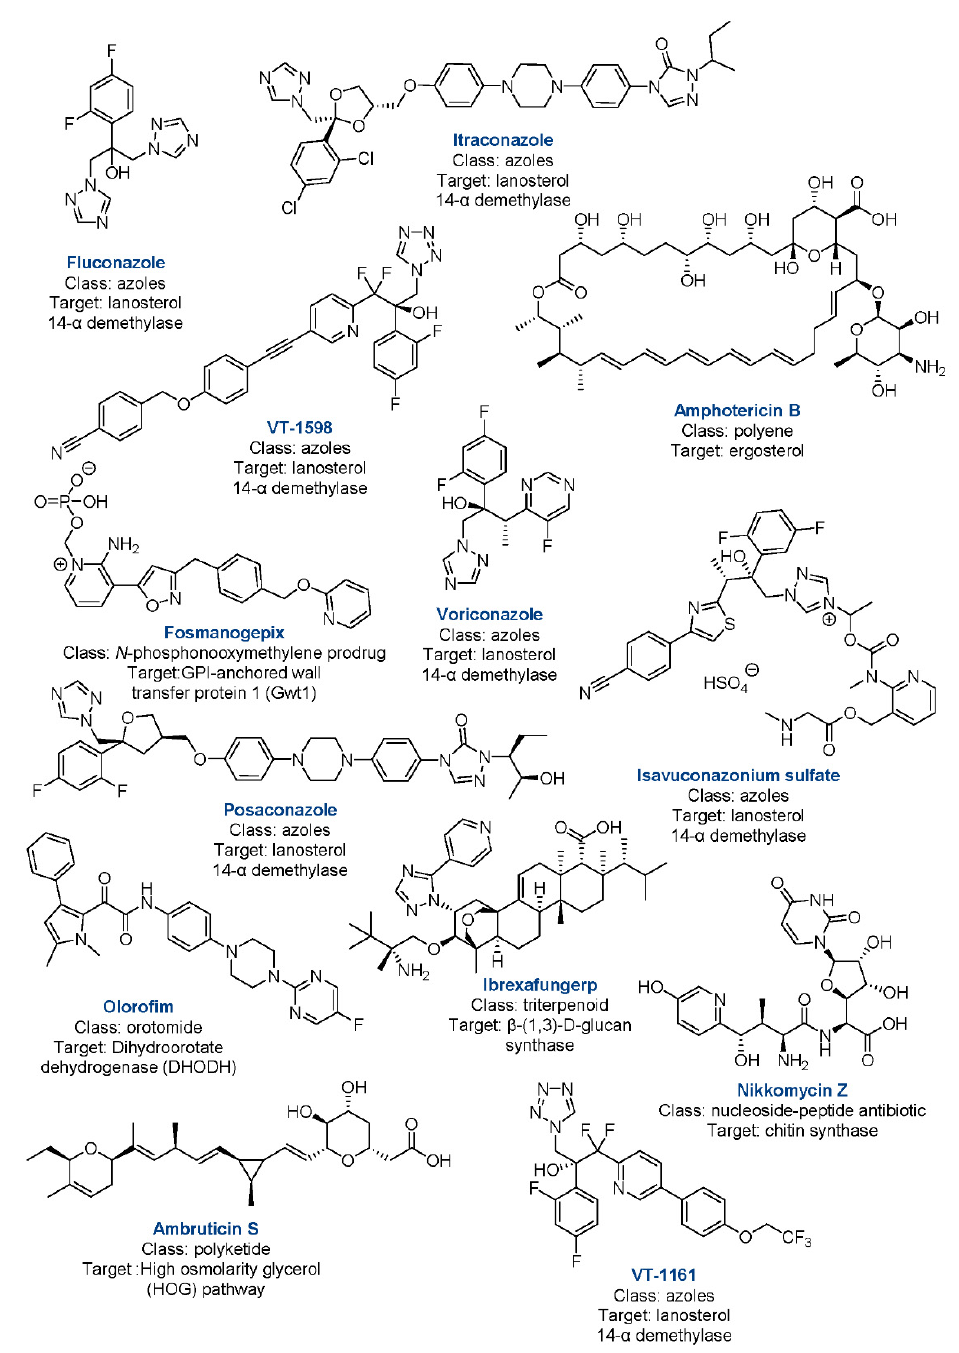
Figure 4. Drugs relevant to CM in current treatment, clinical trials, or preclinical development with class and